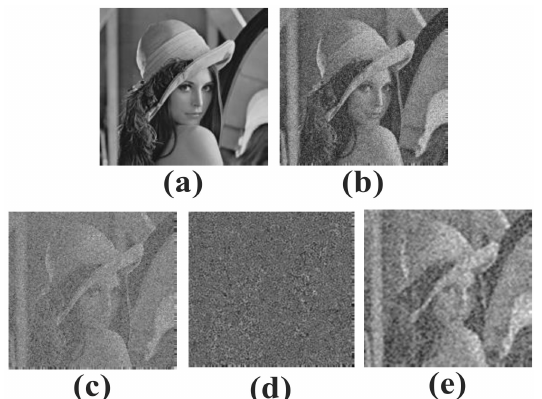
Figure 5. Results of decomposition by bidimensional empirical mode decomposition (BEMD) for the raw Lena image: ( a ) the original image, ( b ) the noise polluted image, ( c ) the decomposed bidimensional intrinsic mode function (BIMF) 1, ( d ) the decomposed BIMF 2, ( e ) the residue.